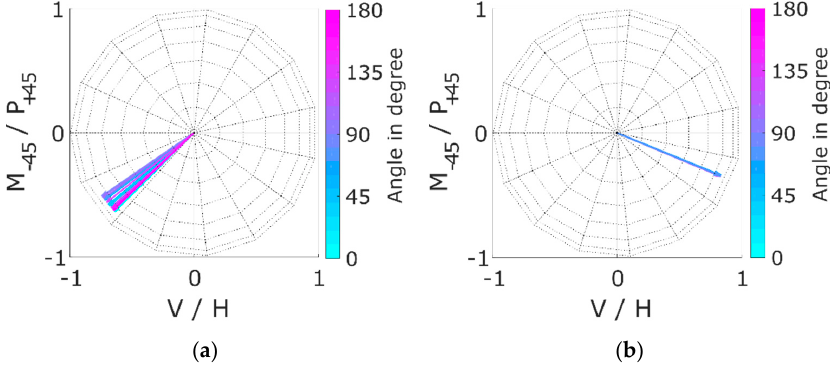
Figure 9. Stokes vector of the fast axis of retardation for different sample orientation of the transparent collagen film in transmission ( a ) and reflection ( b ). The vectors are averaged over a given sample size of three and each angle was measured twice because the sample was rotated by 370°.